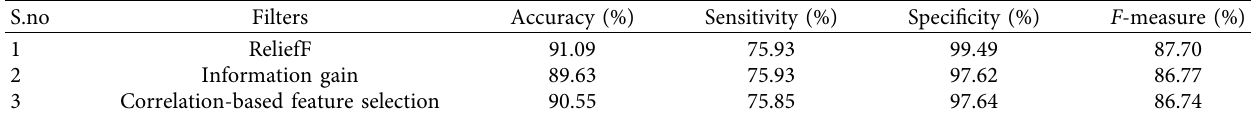
Table 7: Top 3 Filter approaches performance for gene microarray dataset.